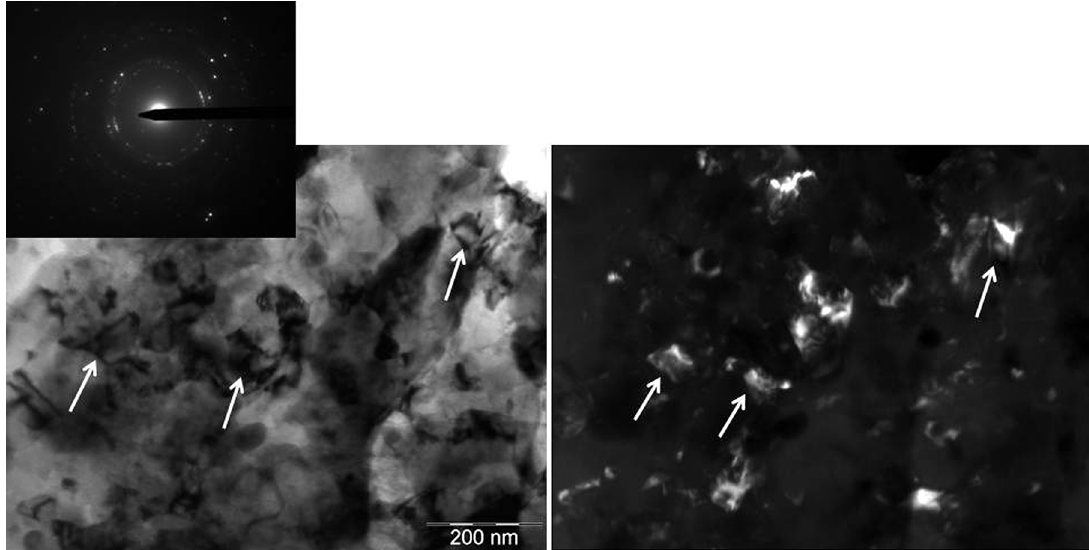
Table 1. Dislocation densities of high energy milled powder calculated using equation 2.